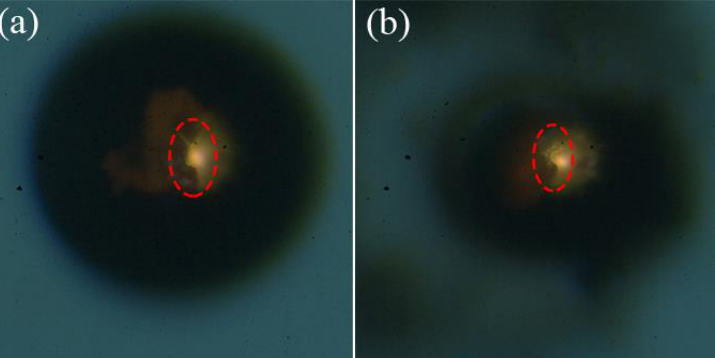
Figure 12. The transformation of flame structure during the combustion of individual Mg microparticle. ( a ) Flame structure before transformation, ( b ) Flame structure after transformation.